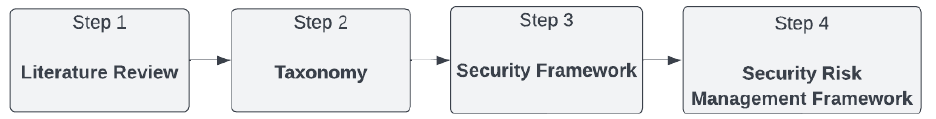
Figure 1. The research methodology phases: ( Step 1 ) conduct a literature review. ( Step 2 ); taxonomy design.; ( Step 3 ) map the data from the taxonomy to the HIoT BC-IdM system.; ( Step 4 ) develop the cybersecurity risk management